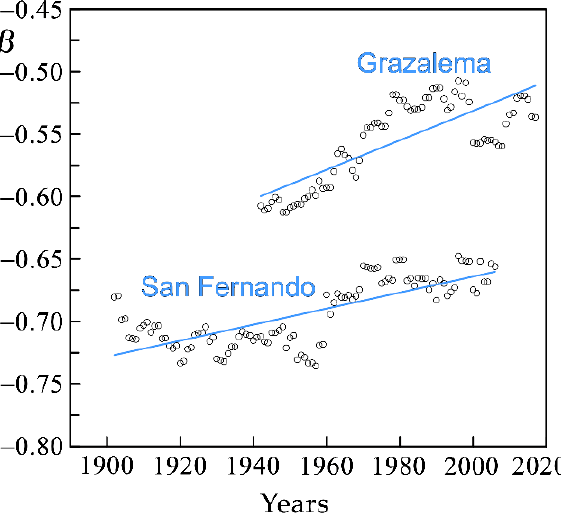
Figure 12. Temporal evolution of the scaling parameter β in Grazalema and San Fernando (C á diz). Blue lines indicate slightly increasing trends.